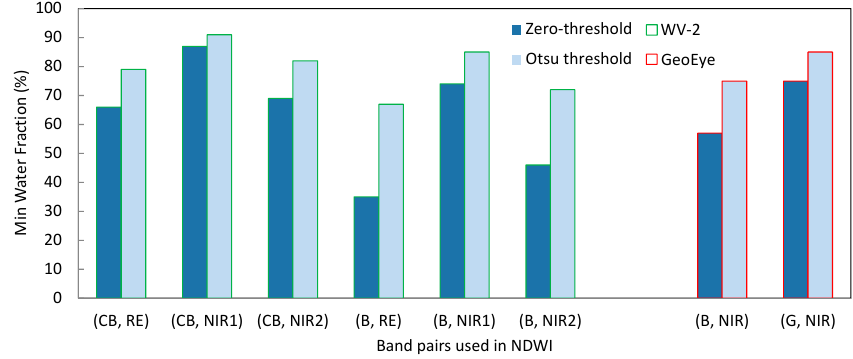
Figure 11. Minimum water fractions corresponding to zero-threshold and Otsu’s threshold for several NDWIs using synthetic WV-3 and GeoEye spectra; CB and RE stand, respectively, for coastal-blue and red-edge bands.